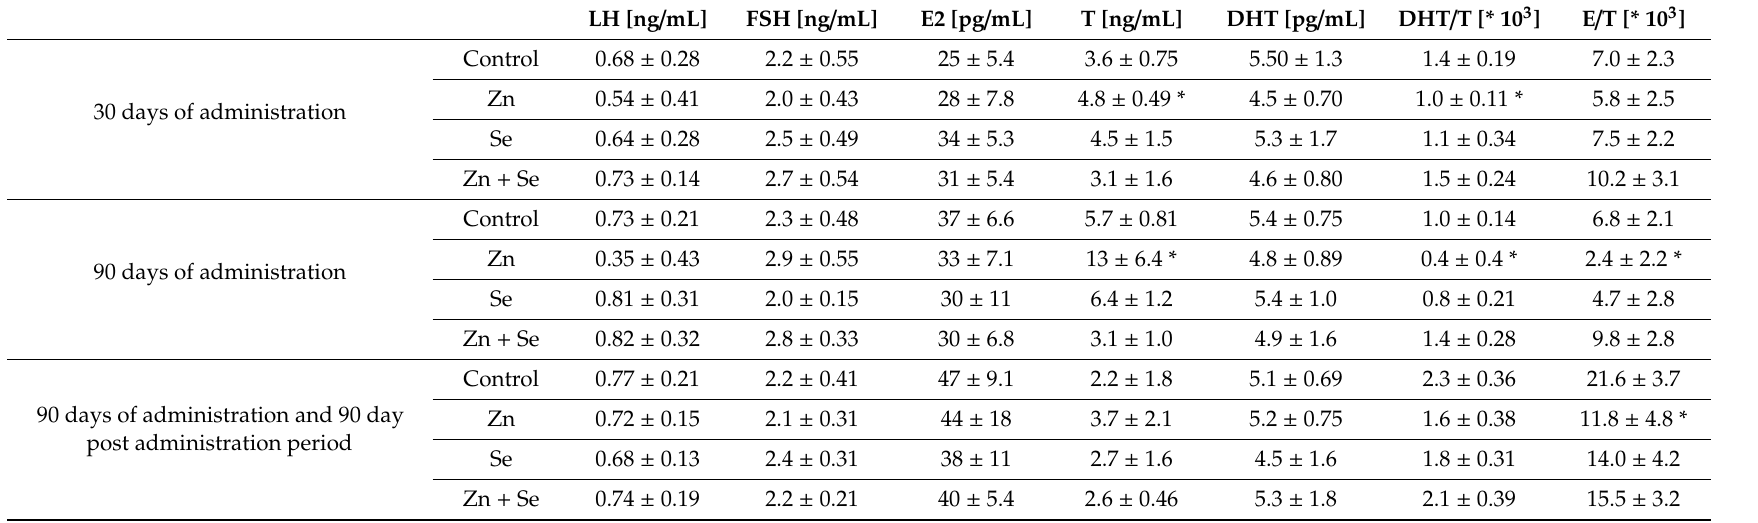
* results statistically significant in comparison with control group, p ≤